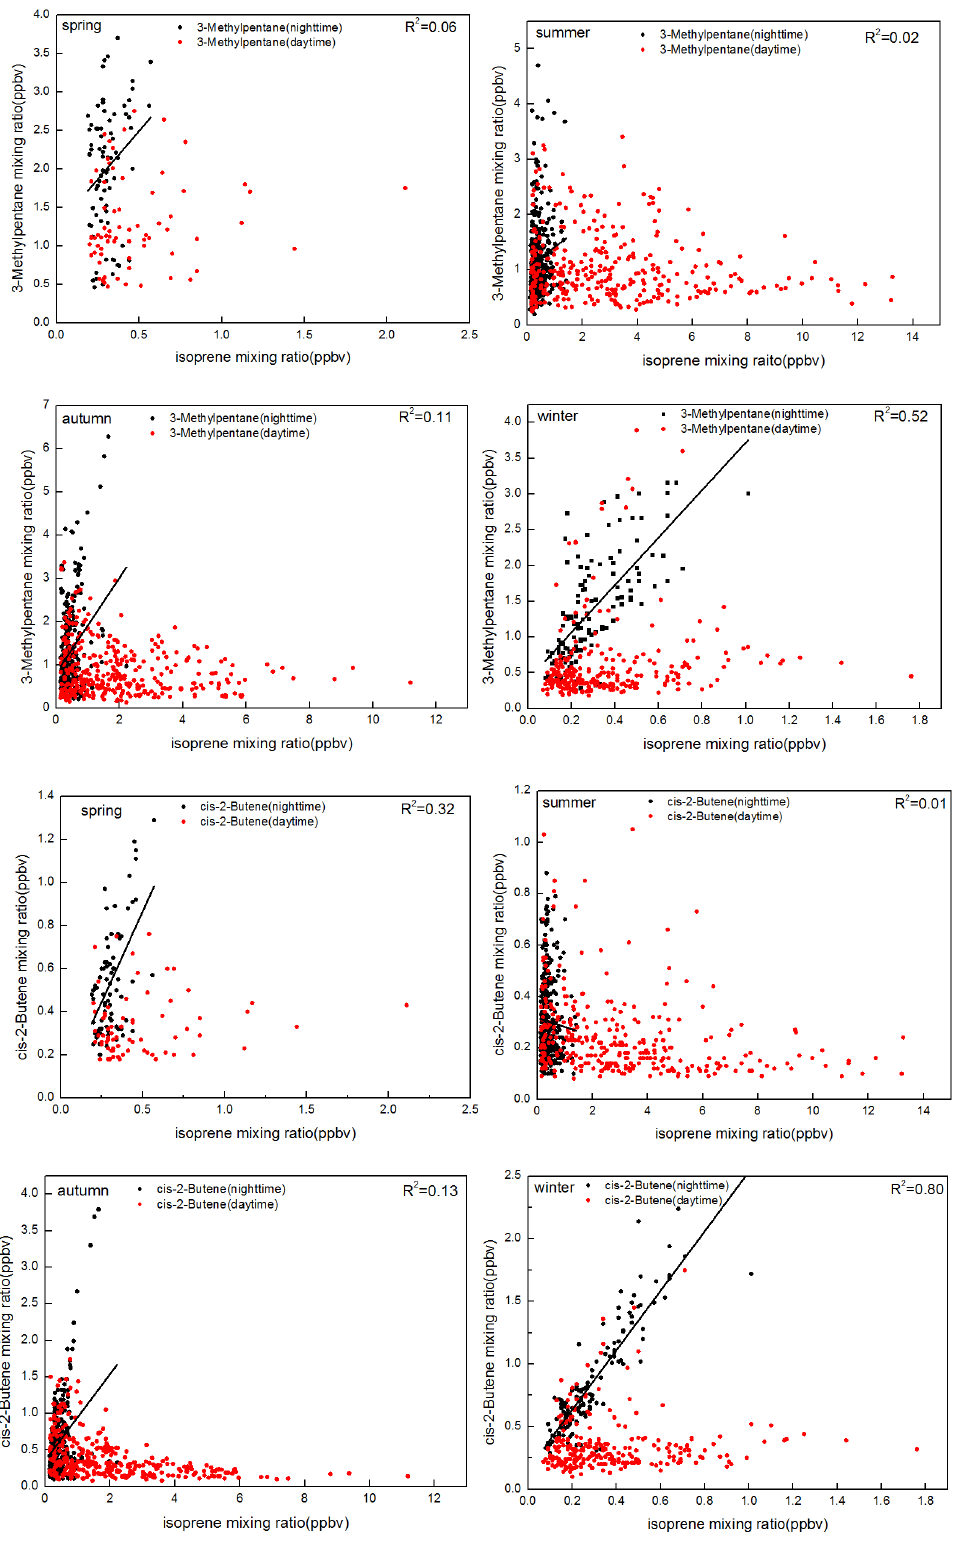
Figure 5. Mixing ratios of isoprene versus 3-methylpentane and cis-2-butene, respectively in each season from June 2011 to May 2012 at GPACS. Red circles denote the data for the daytime (7:00–18:00 LT), and black circles denote the data for the night-time (19:00–6:00 LT). Black lines represent the regression lines fit to the night-time samples (black